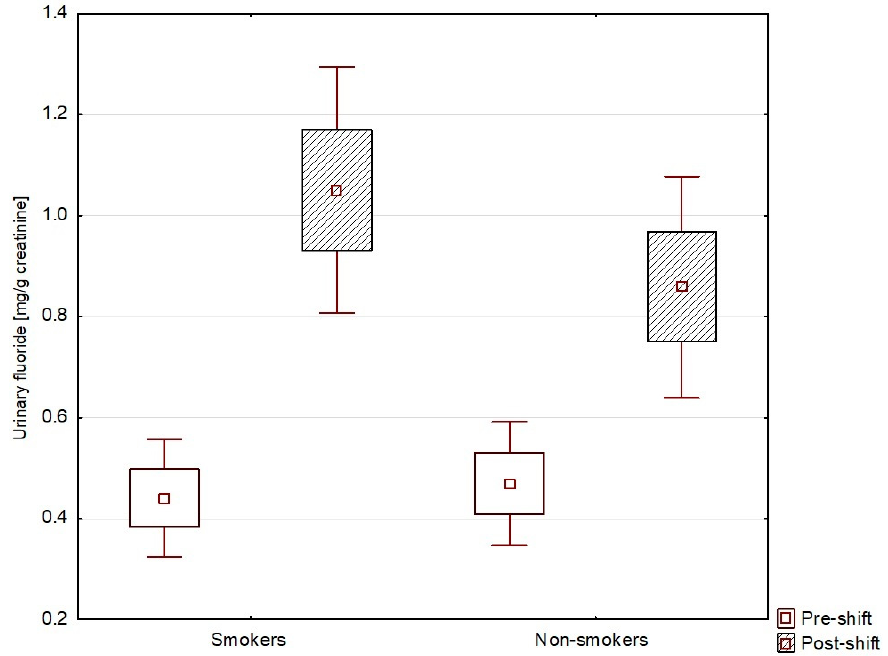
Figure 6. Comparison of pre- and post-shift urinary fluoride concentration according to smoking habits (boxplot: mean ± SE; whisker: mean ± 0.95 conf. interval).